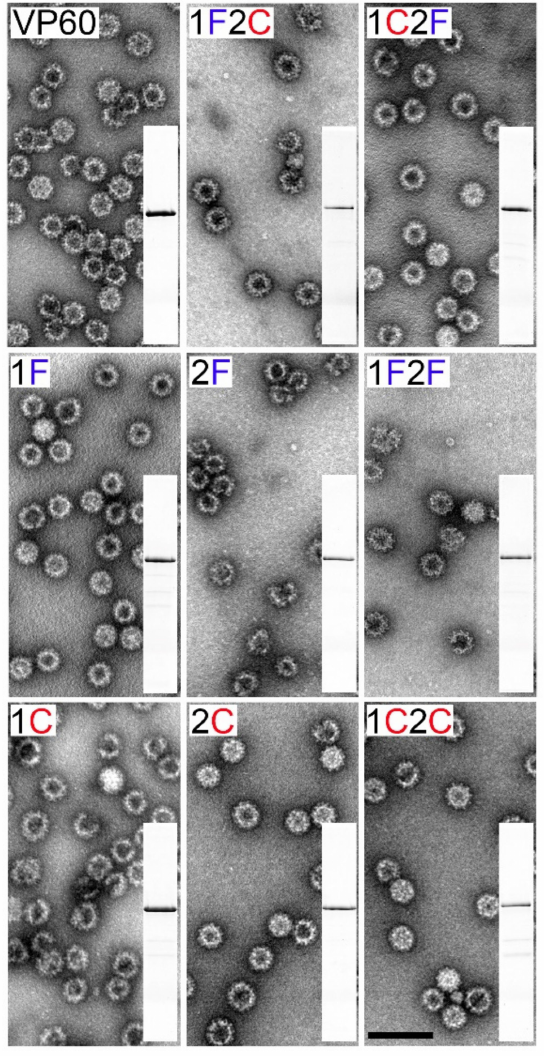
Figure 3. Electron microscopy of negatively stained VP60-related assemblies. Insets show the SDS–PAGE analysis of the purified VP60 chimeric constructs (top, left). Scale bar = 100